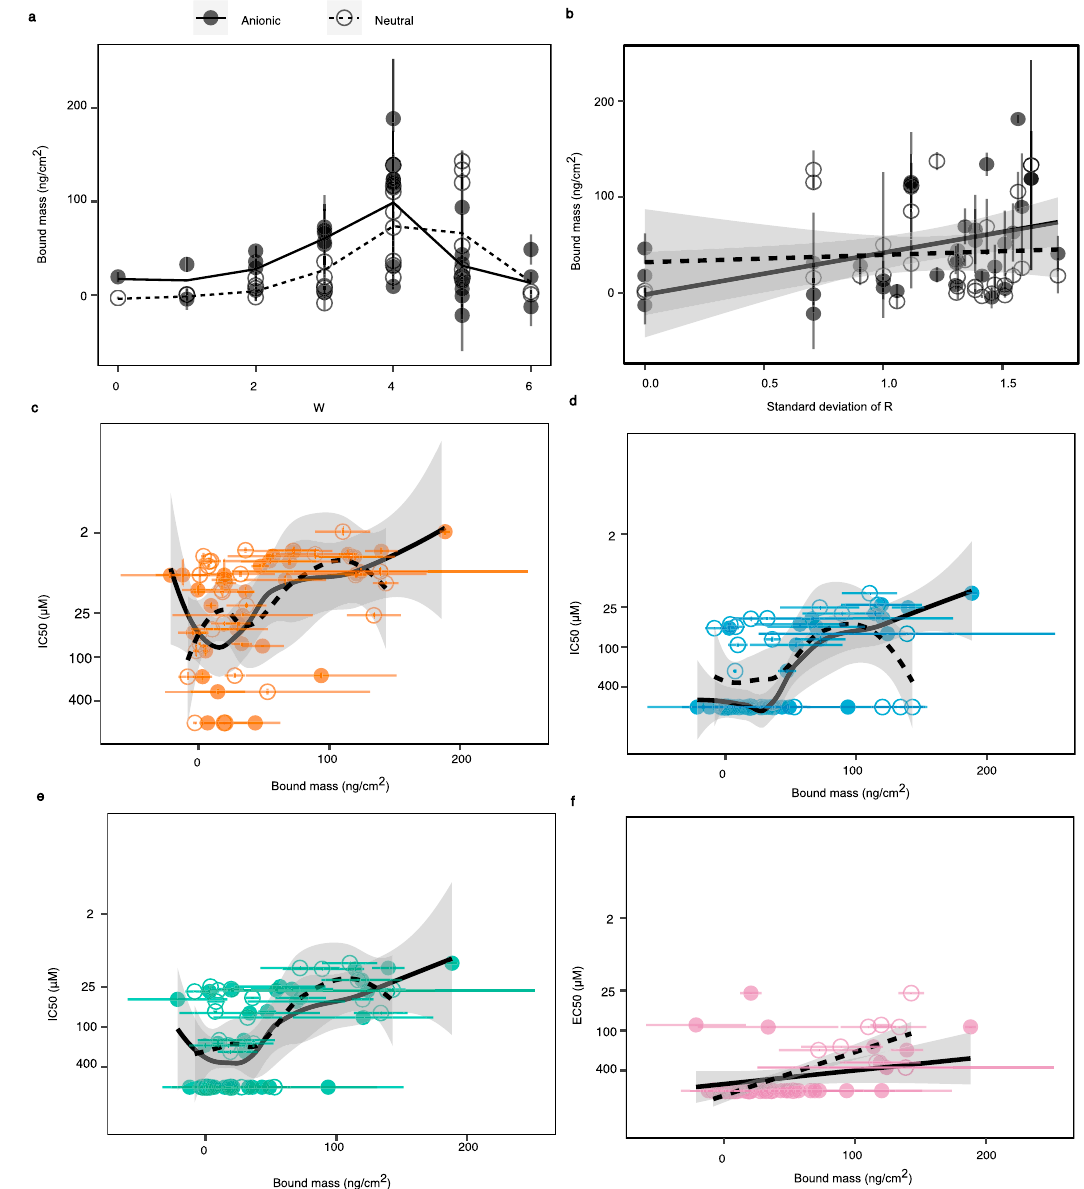
Fig. 4 Membrane binding capacity of heptapeptides. a Comparisons of bound mass of selected heptapeptides to anionic and neutral membranes against their W content. b Comparison of bound peptide mass to anionic and neutral membranes with distribution of R residues in the peptides (in the form of the positional standard deviation of R). The solid and dashed lines indicate the linear regression between bound mass and positional standard deviation of R for anionic and neutral membranes, respectively with the solid and outlined ribbons indicating the 95% con fi dence interval on the regression lines for the respective membranes. Analysis of the relationships between bound peptide mass to anionic and neutral membranes and antimicrobial activity against c S. aureus , d P. aeruginosa and e C. albicans . The solid and dashed lines indicate the LOESS regression between bound mass and log 2 (IC 50 ) deviation of R for anionic and neutral membranes, respectively with the solid and outlined ribbons indicating the 95% con fi dence interval on the regression lines for the respective membranes. f Analysis of the relationship between bound peptide mass to anionic or neutral membranes and haemolytic activity. The solid and dashed lines indicate the linear regression between bound mass and log 2 (EC 50 ) for anionic and neutral membranes, respectively with the solid and outlined ribbons indicating the 95% con fi dence interval on the regression lines for the respective membranes. All error bars shown are ±s.e.m. ( n = 4) peptides were used